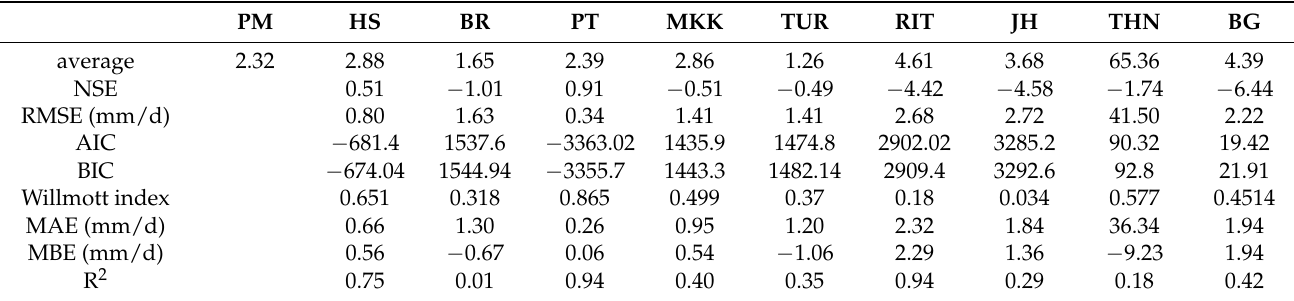
Table 2. Statistical indicators for the performance of the ETo estimation methods against the FAO–PM ETo estimation